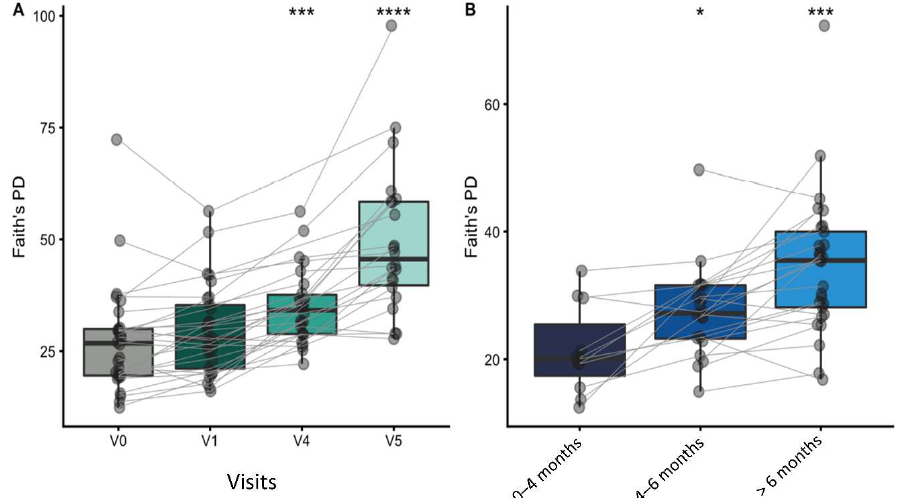
Figure 4. Box plots summarizing the changes in Faith’s phylogenetic diversity of gut microbiomes, grouped by study visit ( A ) and age window ( B ). Samples from the same infant are connected by lines. Paired group comparisons were made by Wilcoxon signed rank test between V0 and subsequent visits ( A ), as well as between infants enrolled at 0–4 months compared to older infants ( B ). Significant differences are indicated above the groups: * p < 0.05; *** p < 0.001; **** p < 0.0001.